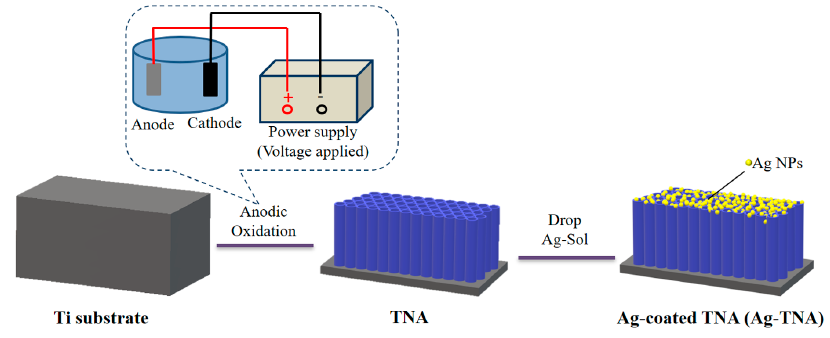
Figure 2. Illustration of TNA and Ag-TNA preparation.